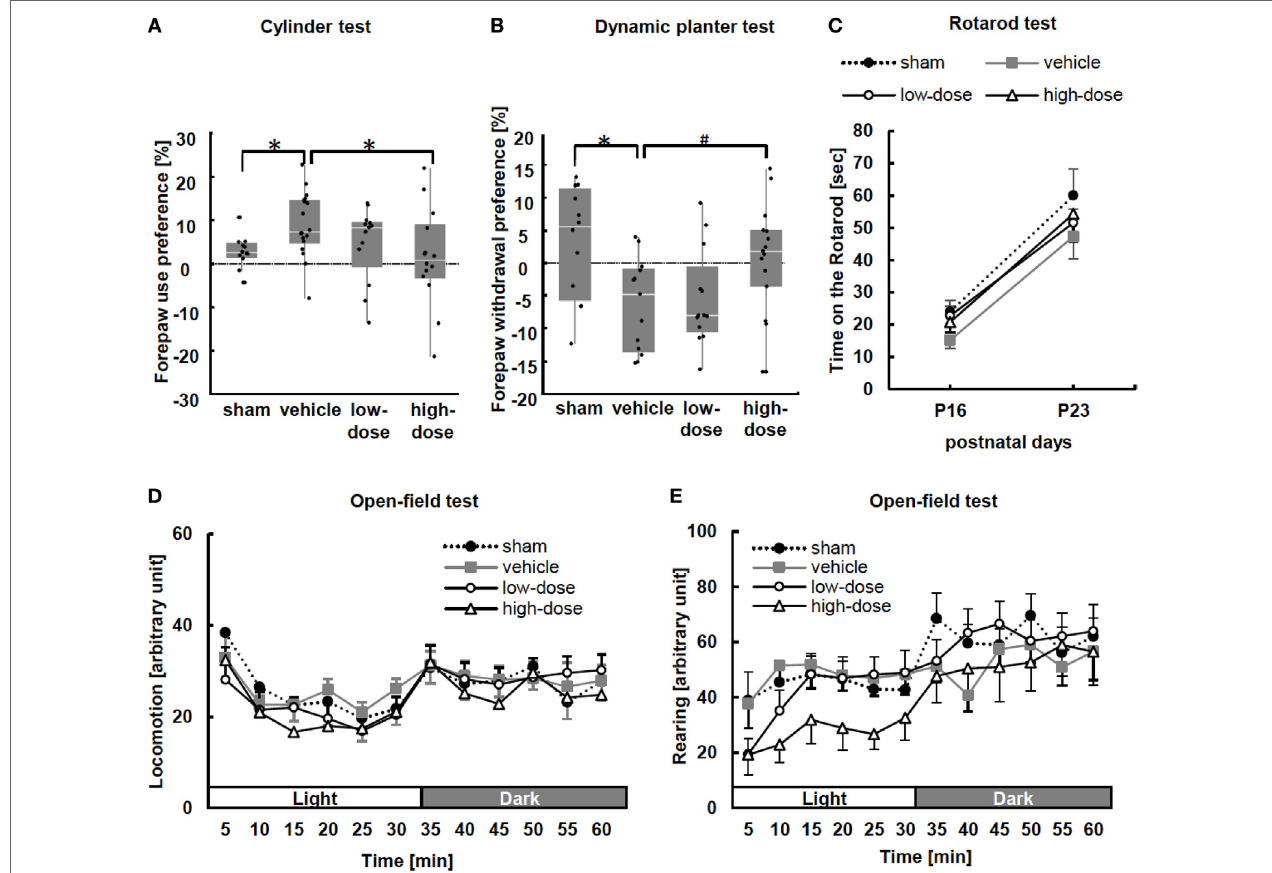
FigUre 3 | Behavioral tests: the cylinder test, dynamic plantar test, rotarod test, and open-field test. (a) In the cylinder test performed at P15, significant asymmetrical forepaw use was observed in the vehicle group. After administration of high-dose umbilical cord-derived MSCs, forepaw preference significantly improved. Wall touches by the left of right forepaw were measured separately, and paw preference with wall touches was calculated as (nonimpaired side [left] − impaired side [right])/(nonimpaired + impaired sides) × 100. * p < 0.05 (sham n = 12, vehicle n = 18, low-dose n = 13, and high-dose n = 14). (b) The dynamic plantar test was performed at P15 to assess the extent of sensory deficit. The forepaw of vehicle mice showed significant asymmetrical dullness compared with that of the sham mice. The high-dose UC-MSC mice showed a trend toward improvement. Average withdrawal time was calculated as (nonimpaired − impaired)/ (nonimpaired + impaired) × 100. * p < 0.05 and # p = 0.092 (sham n = 12, vehicle n = 13, low-dose n = 15, and high-dose n = 15). (c) In the rotarod test at P16 and P23, there were no significant differences among the groups (P16: sham n = 12, vehicle n = 13, low-dose n = 13, and high-dose n = 15; and P23: sham n = 10, vehicle n = 12, low-dose n = 13, and high-dose n = 11). (D,e) The open-field test was performed from P20 to P22. There were no significant intergroup differences with respect to either locomotion, i.e., spontaneous horizontal movement, or rearing, i.e., spontaneous vertical movement ( n = 11–13 in each